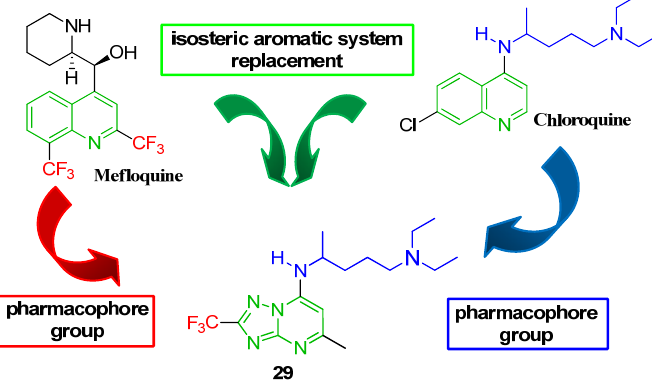
Figure 1. Strategy used in 2004 to obtain 5-methyl-7- N' -( N,N -diethylpentane-1,4-diamine)-2- (trifluoromethyl)[1,2,4]triazolo[1,5- a ]pyrimidine ( 29 ) as an antimalarial bioisostere of quinoline.